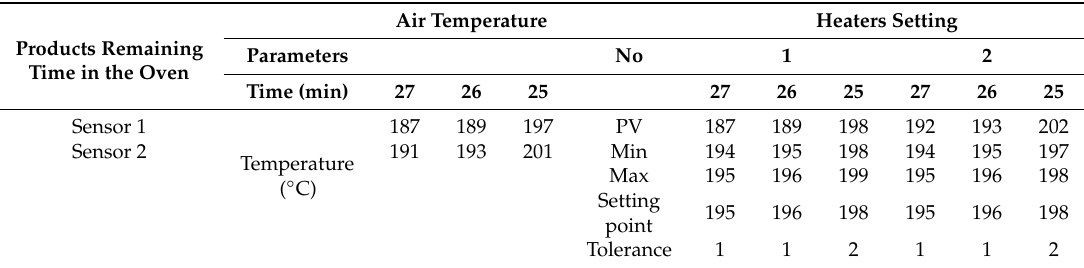
Table 1. Polymerization oven